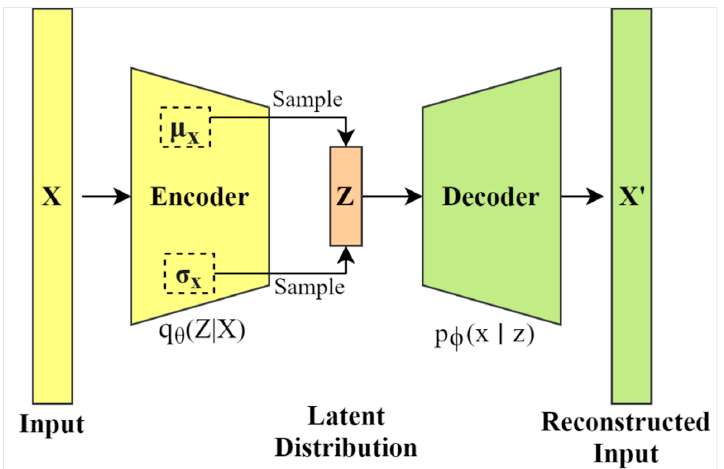
Figure 2. The variational autoencoder (VAE) architecture. X represents the input to the encoder model and Z is the latent representation along with weights and biases ( θ ). model and Z is the latent representation along with weights and biases ( θ